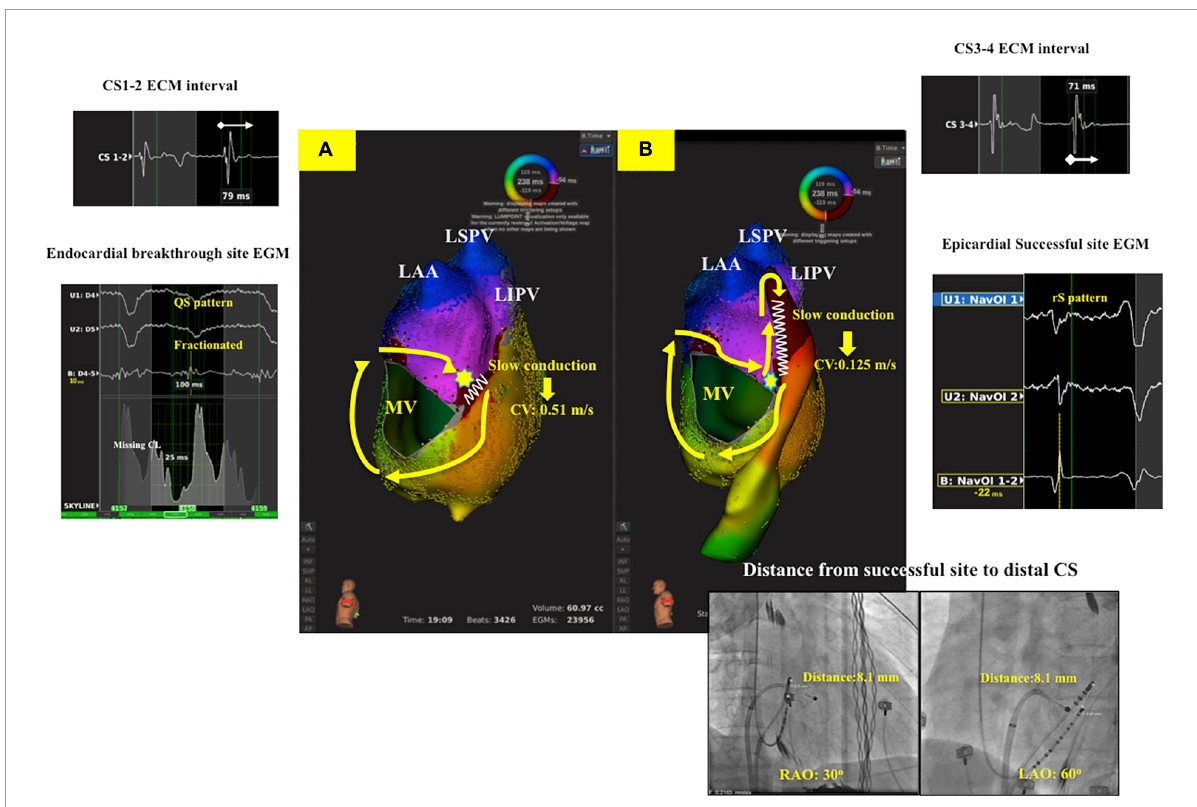
FIGURE3 Ultra-high-density mapping during perimitral AFL in a patient with epicardial successful ablation (Group 2 patient). (A) : Activation map of LA showed clockwise perimitral AFL. Missing cycle length with color jump to epicardial site with focal breakthrough (Yellow star) at posterolateral mitral line with slow conduction (CV: 0.51 m/s). (B) : Activation map of LA and CS showed complete whole circuit of perimitral atrial flutter to epicardial region. Slow conduction was noted at distal CS (CV: 0.125 m/s) with the local unipolar signal at epicardial successful site revealing rS pattern, and the distance between ablation catheter to distal CS1-2 was 8.1 mm. The local EGM interval of distal CS was fractionated (CS1-2: 79 ms, CS3-4: 71 ms). LA, left atrium; CV, conduction velocity; AFL, atrial flutter; CS, coronary sinus; CW, counterclockwise; EGM,